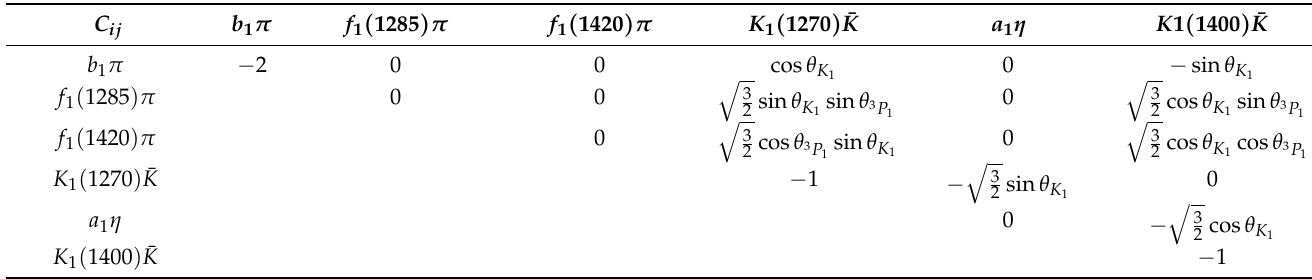
Table 7. C ij coefficients in Equation (16) for axial and pseudoscalar pairs coupled to J PC = 1 − + in S -wave and I = 1.